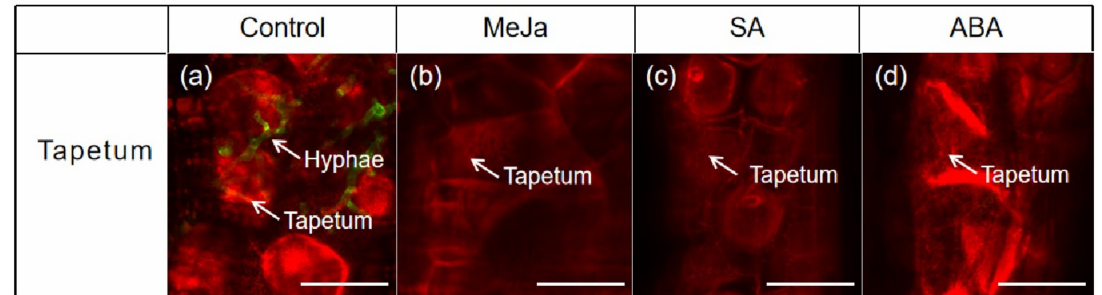
Figure 5. Effect of exogenous hormones on tapetum cells of anther in susceptible cultivar (Dongxuan 3). ( a ) hyphae were located on the tapetum cells in control anthers; ( b ) There were no hyphae on tapetum cells of anther in MeJa treated samples; ( c ) There were no hyphae on tapetum cells of anther in SA treated samples; ( d ) There were no hyphae on tapetum cells of anther in ABA treated samples. Scale bar = 25 µ m.